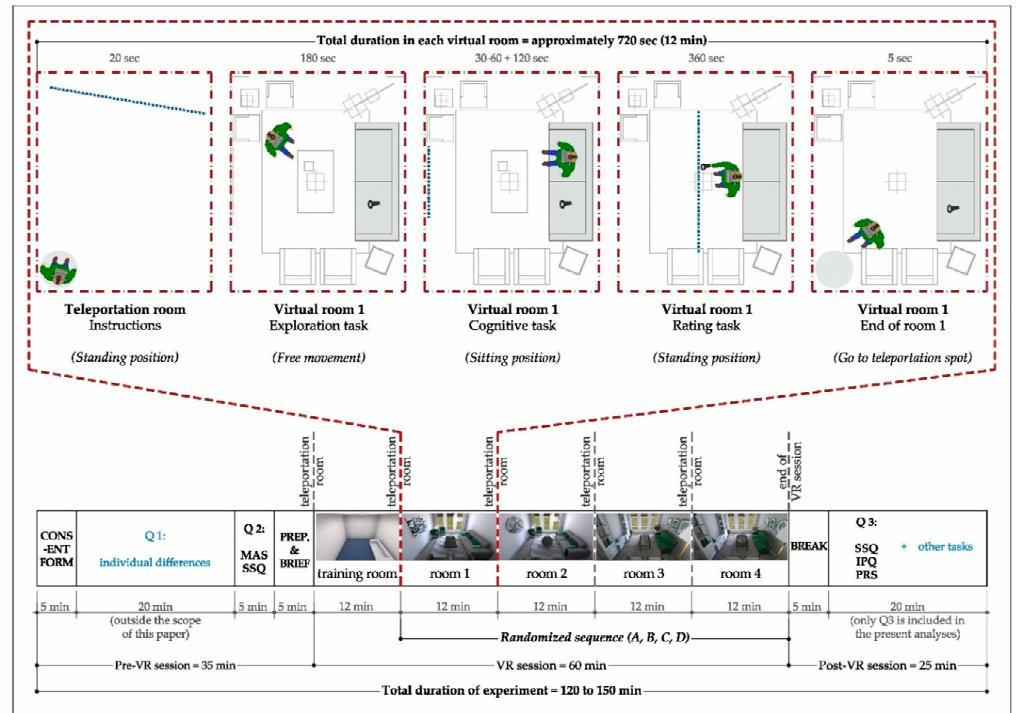
Figure 3. Details of the experimental paradigm. Bottom: The bar shows all phases of the experiment (pre-VR, immersive, and post-VR sessions) along with the respective approximate duration. The mentioned durations are based on the average of the time spent by different participants. Up: The upper layouts display the sequence of events denoting tasks and instructions in each of the virtual environments. Room AM (angular modern) is displayed in a top view layout as an example. The average duration in each virtual room was 12 min (with an approximate total of 60 min). Some events were fixed and had a predefined time (e.g., teleportation room, exploration tasks, cognitive task), while others depended on the participant’s speed (e.g., reading cognitive task instructions and readiness to start, rating tasks, moving back to teleportation spot). Q1 and tasks in the last section mentioned as “other tasks” are excluded from the present analyses. Note: SSQ = simulation sickness questionnaire, IPQ = IGroup presence questionnaire and PRS = perceived restorativeness